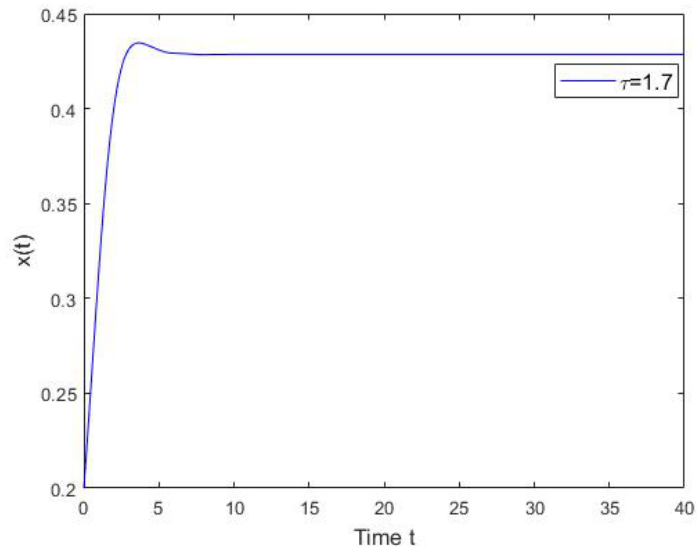
Figure 4. The numerical solution the system in Equation (15), where V = 3 and C =